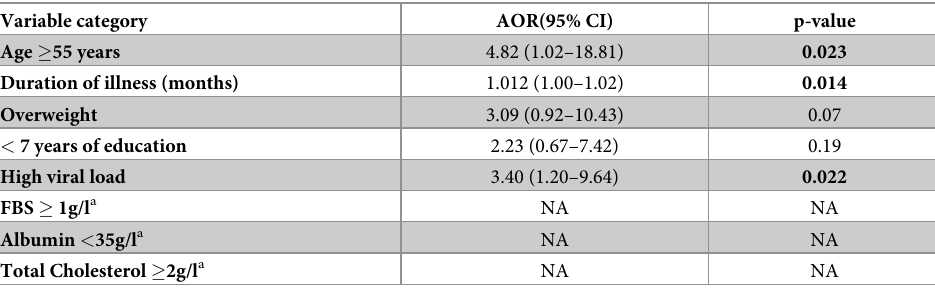
Table 9. Predictors of neurological manifestations in chronic hepatitis C patients.